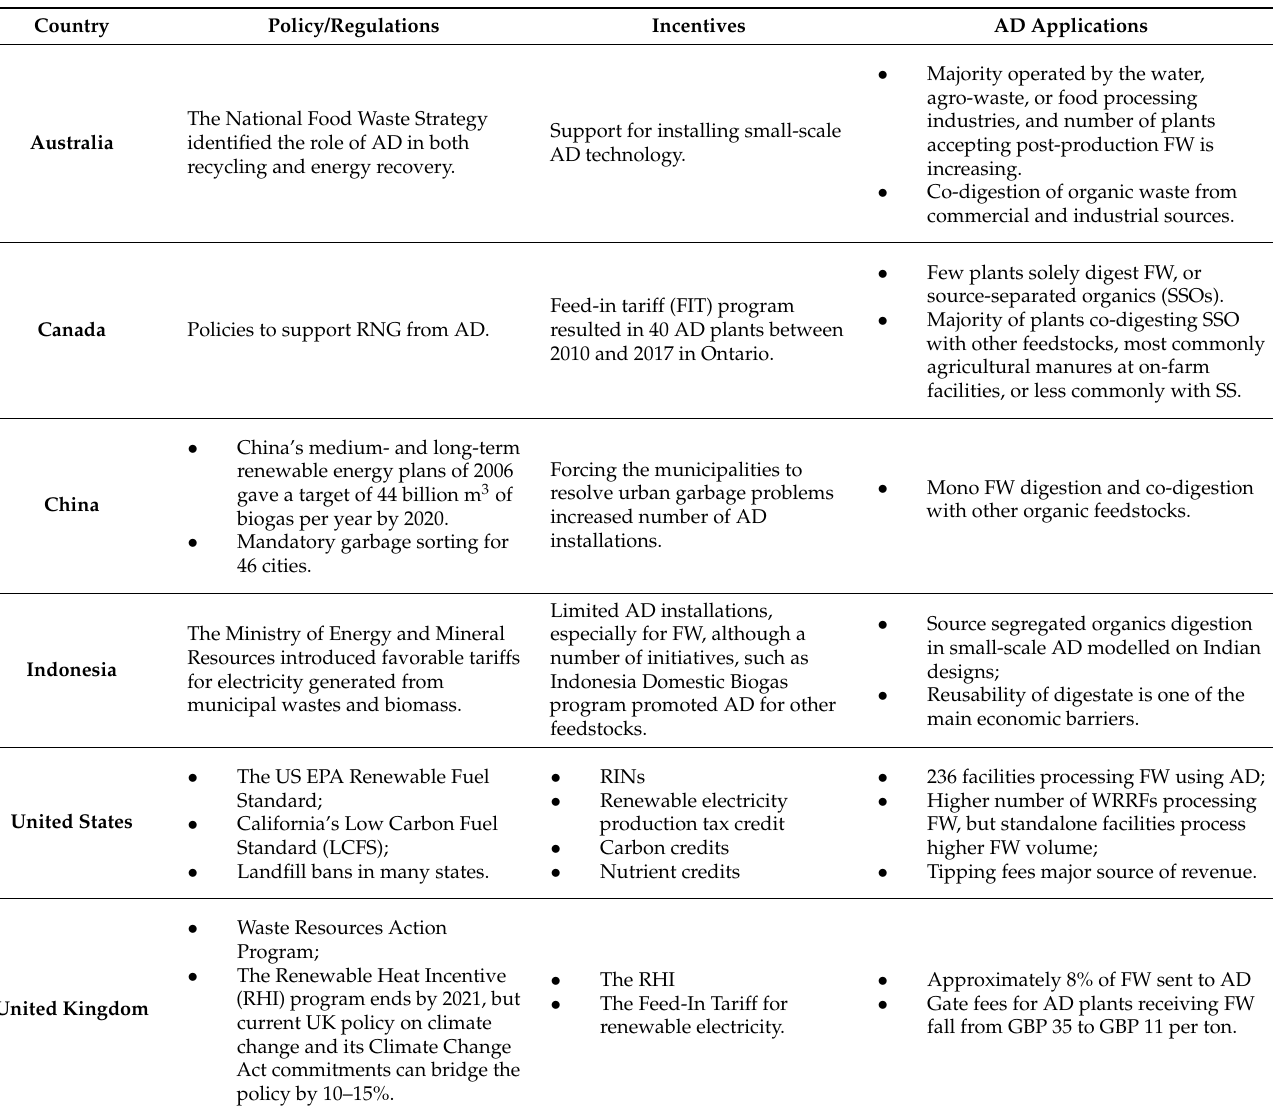
Table 1. Policies/regulations of 12 countries promoting AD for organic wastes. Copyright 2021 by Elsevier